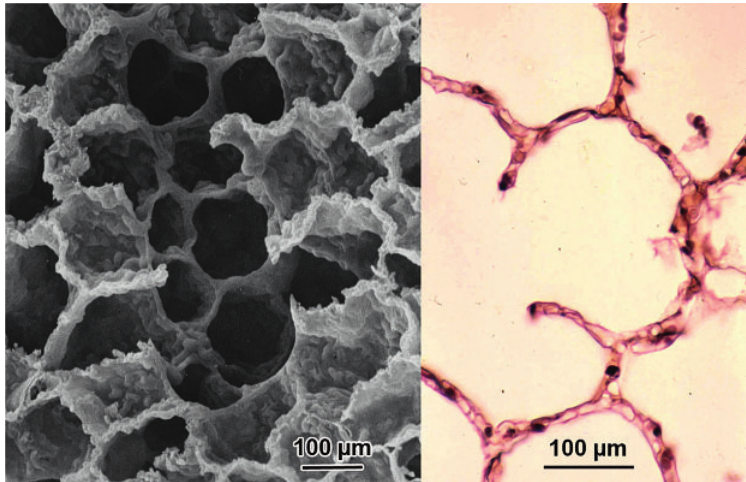
Figure 17 Alveolar duct shown (A) in scanning electron micrograph to illustrate the relation of alveoli, septa and ducts with the network of alveolar entrance rings forming the wall of the duct, and (B) in light micrograph where the elastic fibres are stained black to demonstrate the strong fiber support of the free edge of the alveolar